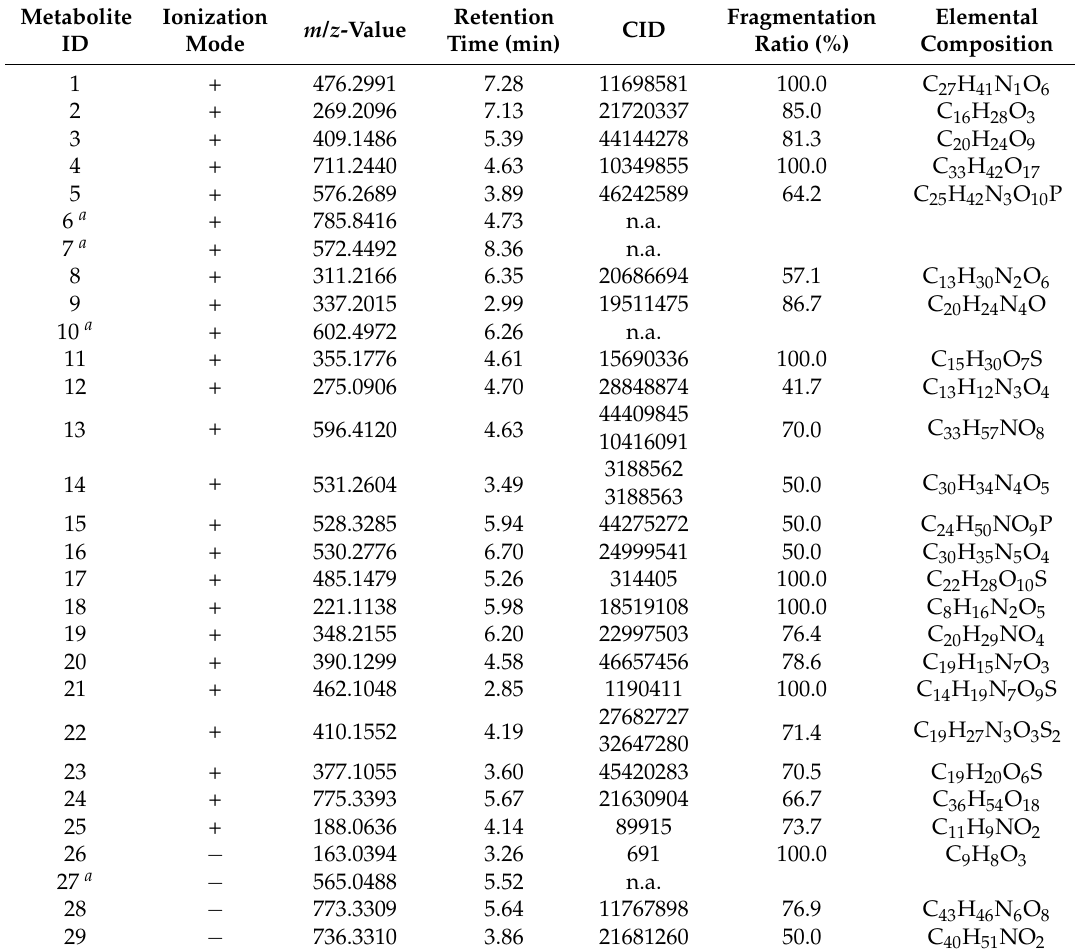
Table 3. Metabolites that were assigned a role in both carotenoid metabolism and the salinity response. These metabolite ions were labeled with an identification number ( i.e. , Metabolite ID) for